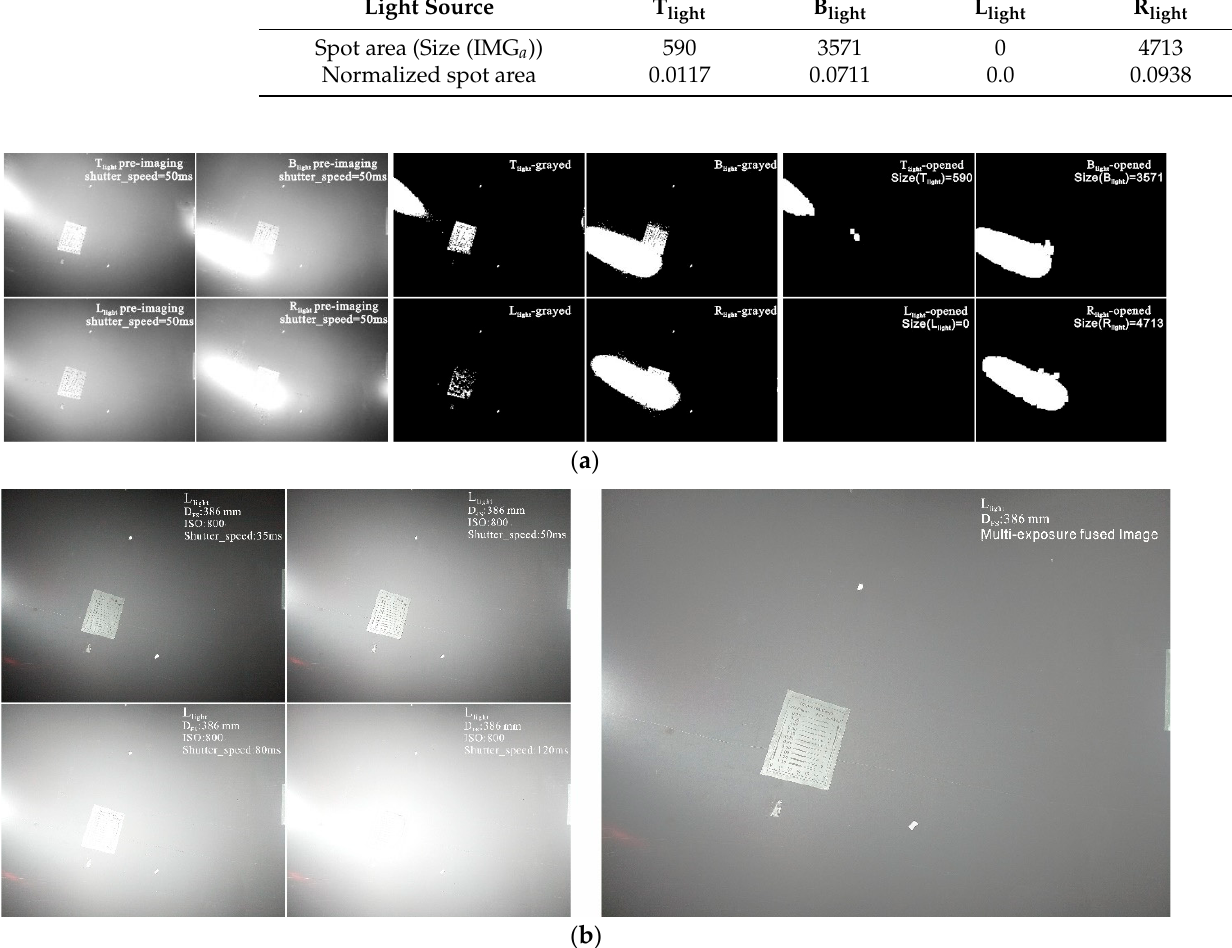
Table 2. Statistics of pre-imaging overexposures.